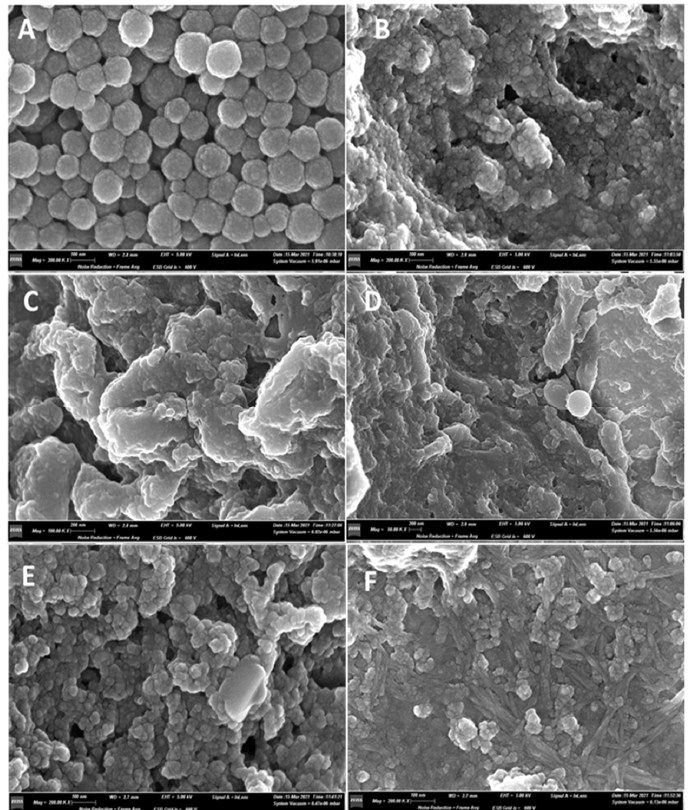
Figure 2. FE-SEM images of sepia melanin after LMCS treatments. Panel ( A ): native sepia melanin. Panel ( B ): sepia melanin after treatment with LMCS ABTS/V. Panel ( C ): sepia melanin after treatment with LMCS TEMPO/V. Panel ( D ): sepia melanin after treatment with LMCS Syr/V. Panel ( E ): sepia melanin after treatment with LMCS AS/V. Panel ( F ): sepia melanin after treatment with LMCS Va/V.